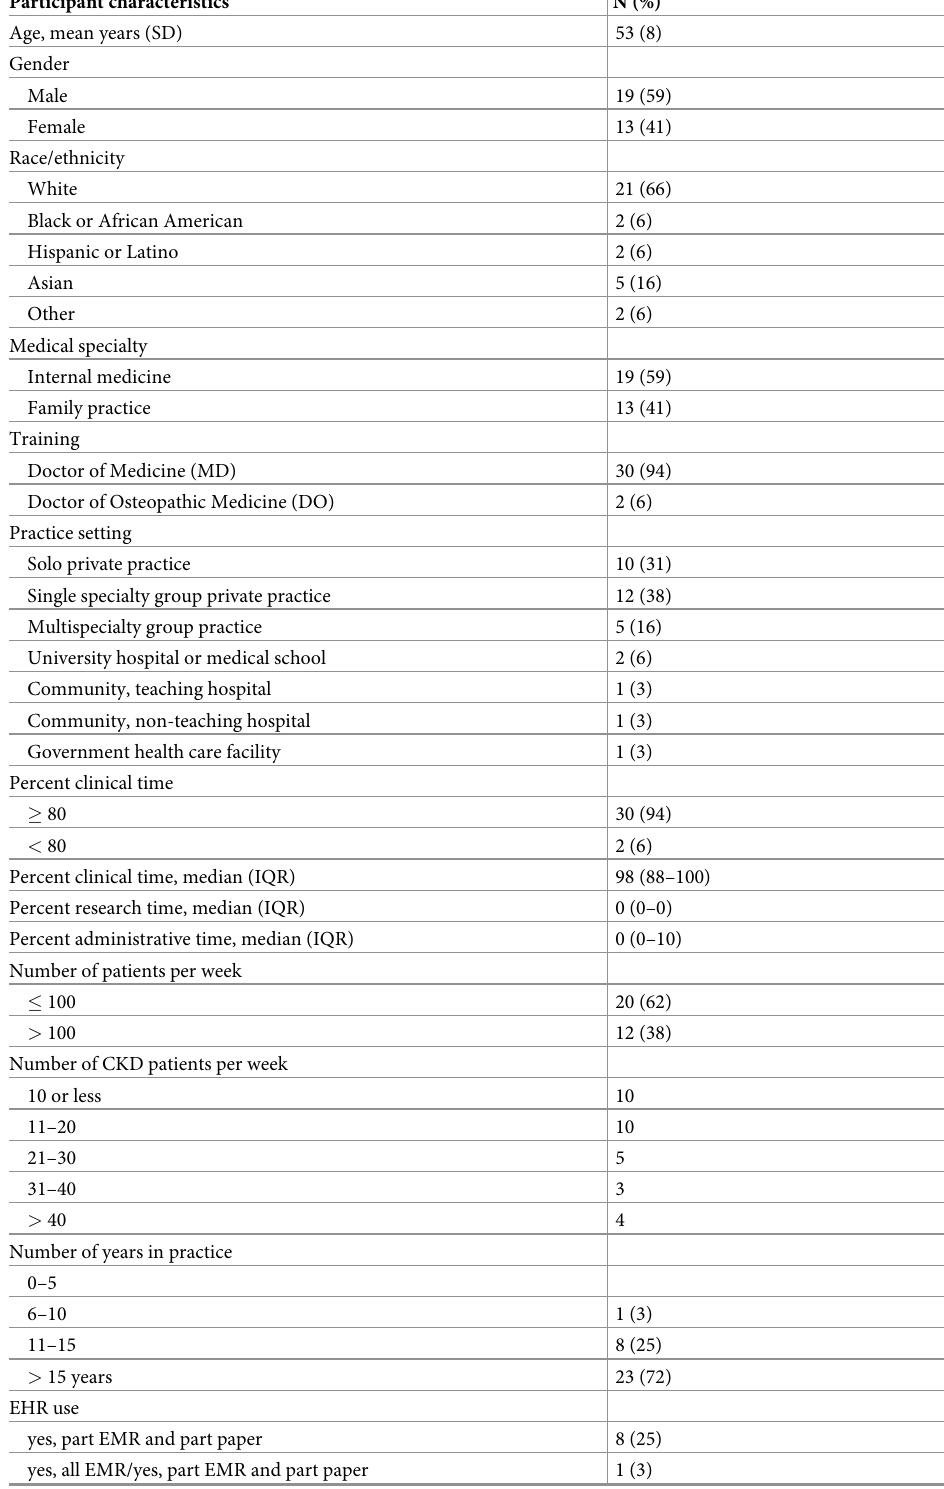
Table 1. Characteristics of primary care physicians (N =